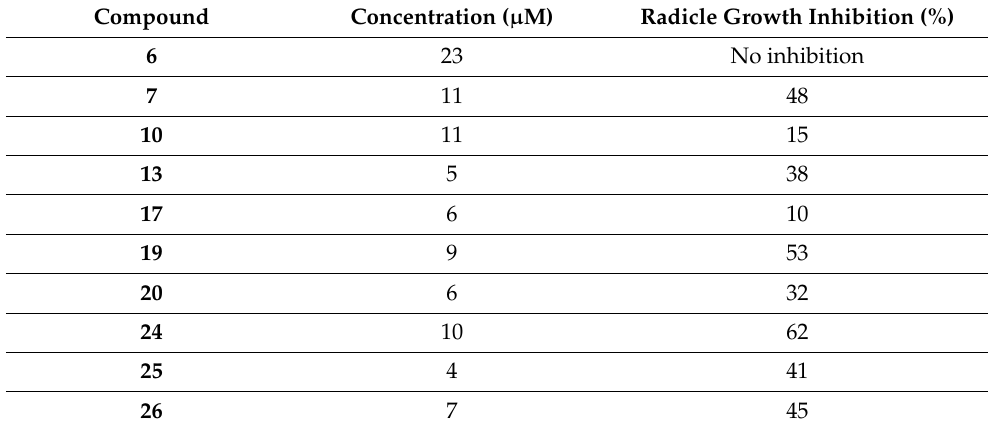
Table 3. Root growth inhibition (%) of the most active compounds at lowest concentration.